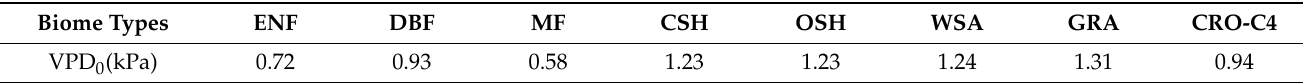
Table 4. VPD 0 of the eddy covariance light use efficiency (EC-LUE) model for various biome types [21]. Biome